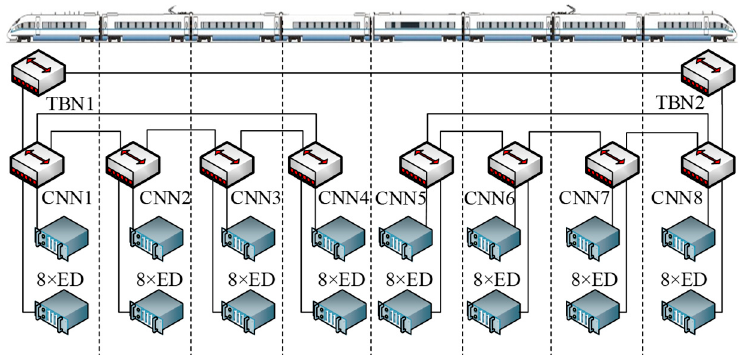
Figure 6. Ethernet train communication network topology.